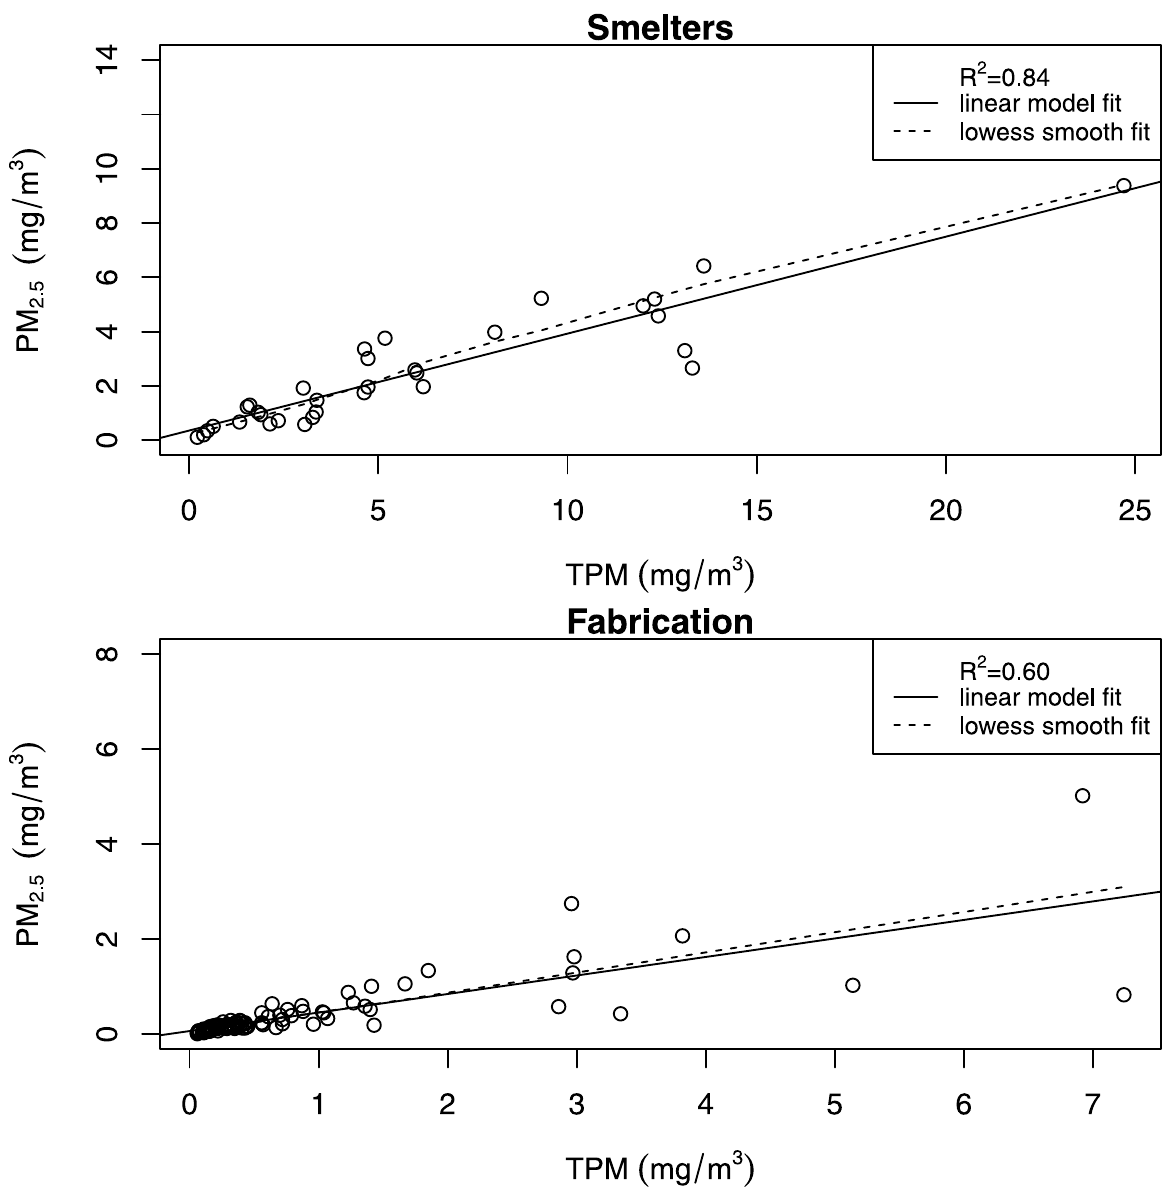
Fig 1. Scatterplot of TPM and PM 2.5 for distinct exposure groups based on an aluminum industry JEM, for two different facility types: smelters (33 DEGs) and fabrication (99 DEGs). Solid lines represent a line of best fit, and the dashed line is a lowess line. Information in this figure is restricted to exposure groups with high confidence exposure values for both TPM and PM 2.5